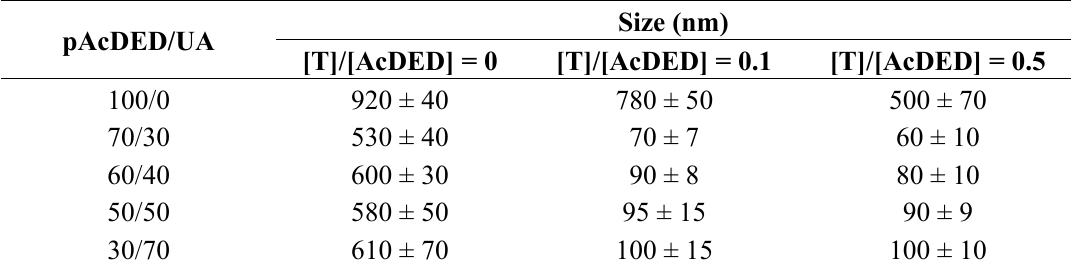
Table 2. DLS size of polymer/UA